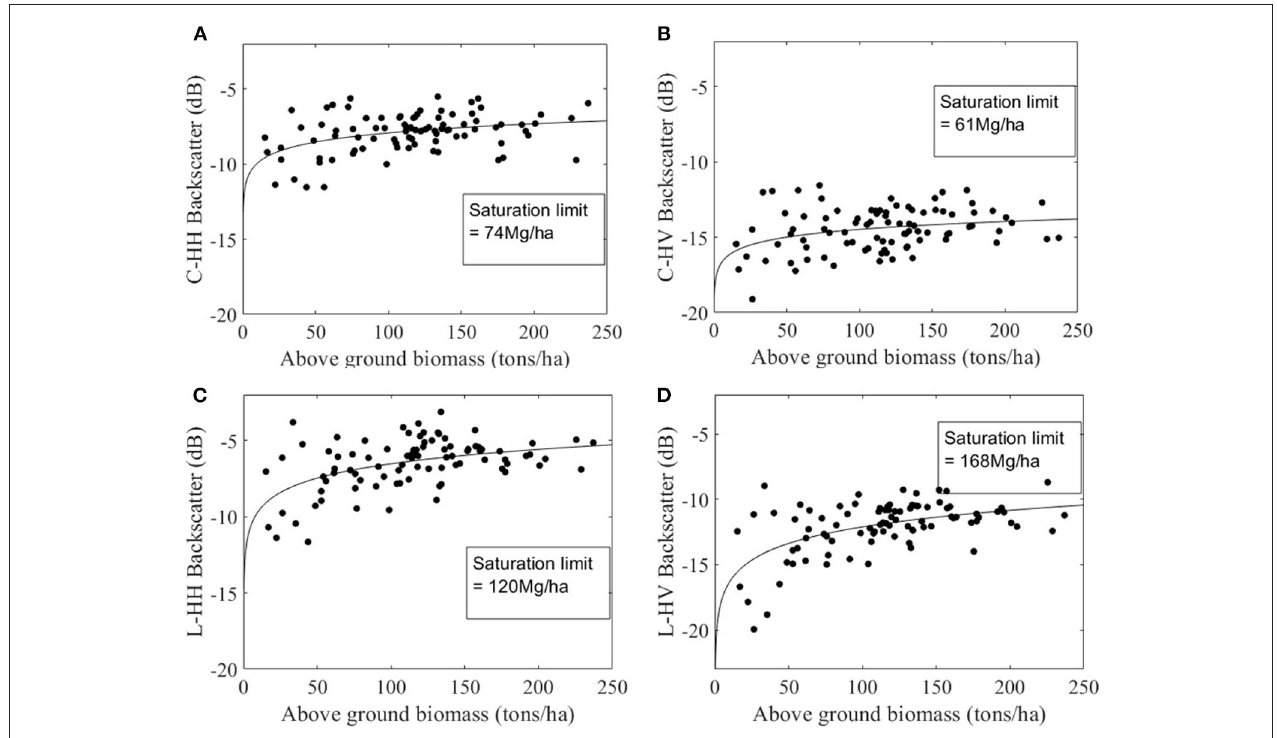
FIGURE 4 | Saturation limit of SAR backscatter with forest above-ground biomass. (A) and (B) shows the scatterplot of HH and HV backscatter of C-band data from Radarsat2 acquired on 08-Mar-2019, (C) and (D) shows the saturation limit of L-band data from ALOS-2/PALSAR-2 acquired on